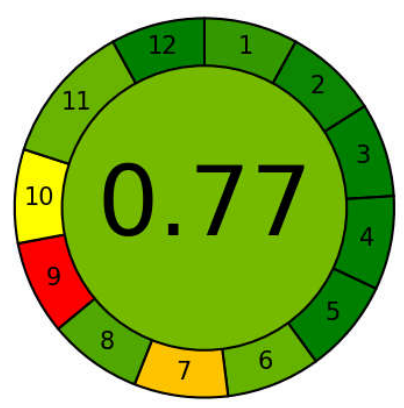
Figure 4. The metabolic stability curve of PX in liver microsomes ( A ) and the regression equation of the linear part of the curve ( B ).